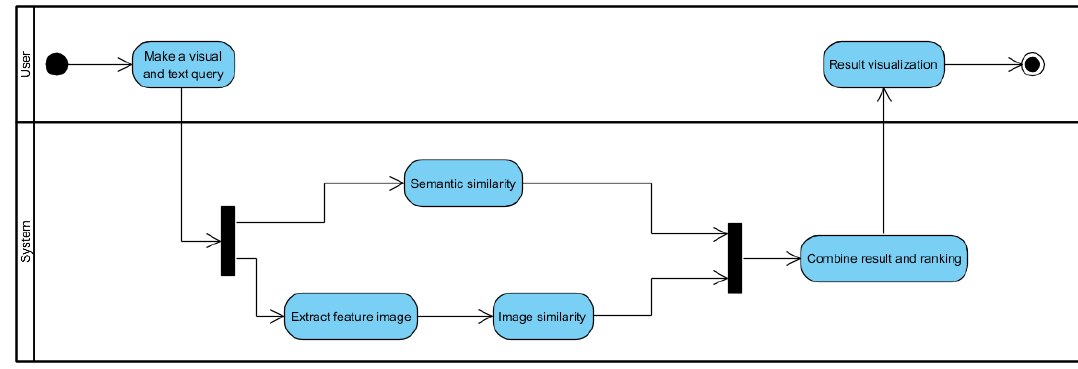
Figure 7. Activity diagram: visual and textual query (Case C).